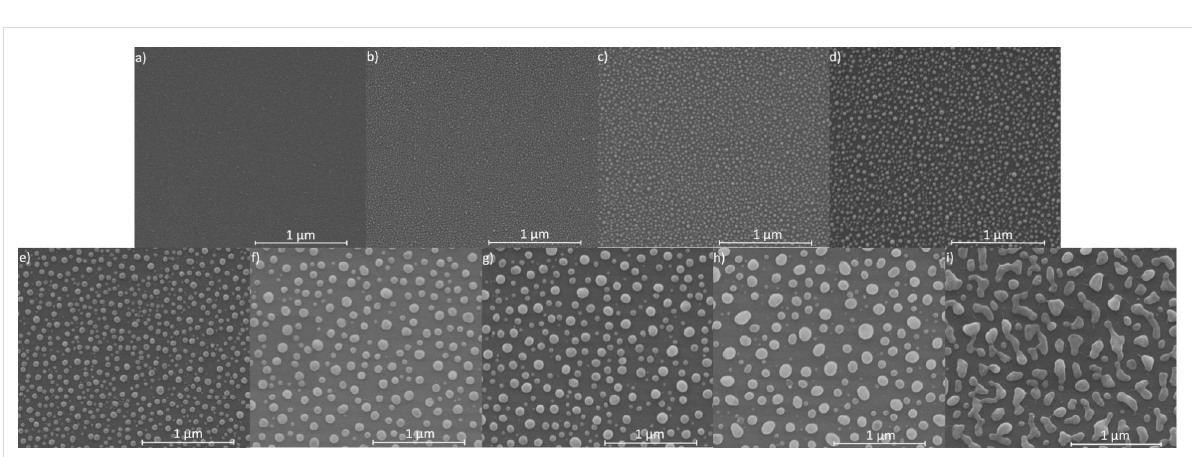
Figure 4: SEM images of the films after annealing at 550 °C for 15 min. Initial film thickness was: (a) 1 nm, (b) 2 nm, (c) 3 nm, (d) 4 nm, (e) 5 nm, (f) 6 nm, (g) 7 nm, (h) 8 nm and (i) 9